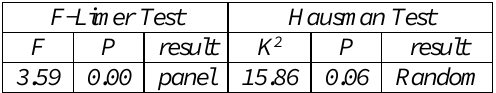
Table 2. Results of F-Limer and Hausman Tests